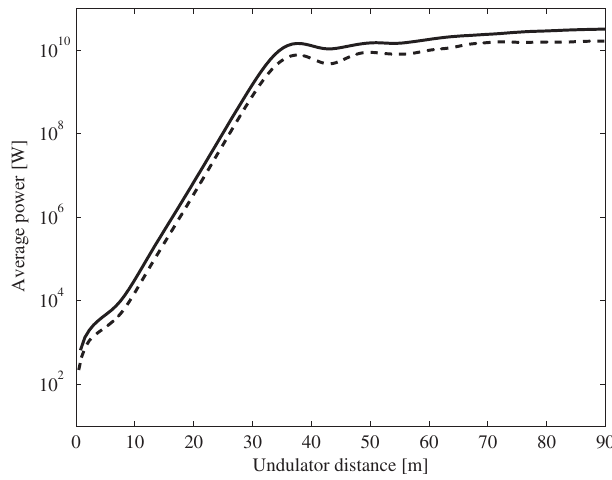
FIG. 2. X-ray pulse average power vs undulator distance. Simulation with the 30 (cid:7) m electron bunch (solid line), simula- tion with the 3 (cid:7) m electron bunch (dashed line).